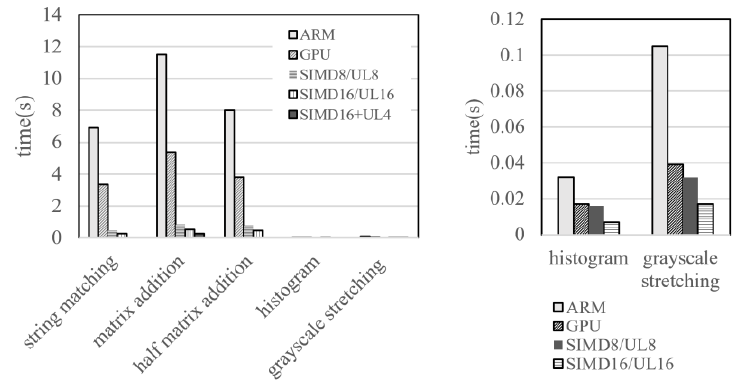
Figure 11. Execution duration to accomplish stages computational tasks.